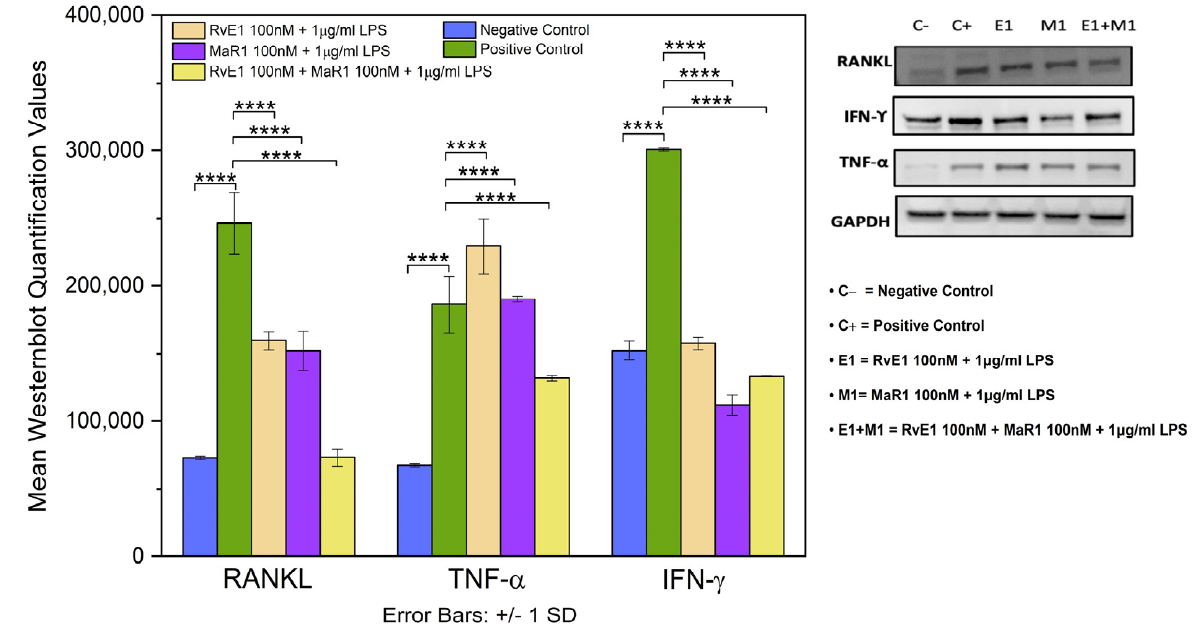
Figure 6 . The right panel of the graph depicts the levels of protein expressions of RANKL, TNF- α , and IFN- γ by Western blot across the five study groups. Positive control has significantly higher RANKL and TNF- expression than the other four groups (Negative control, RvE1 + LPS, MaR1 + LPS, and RvE1 + MaR1 + LPS) ( p ≤ 0.0001). Negative control group and Group 5 (RvE1+ MaR1 + LPS) have comparable levels of expression ( p > 0.05). The left panel represents the normalized average values of three experimental repeats ( n = 3) with their significant expressions. (**** p ≤ 0.0001).